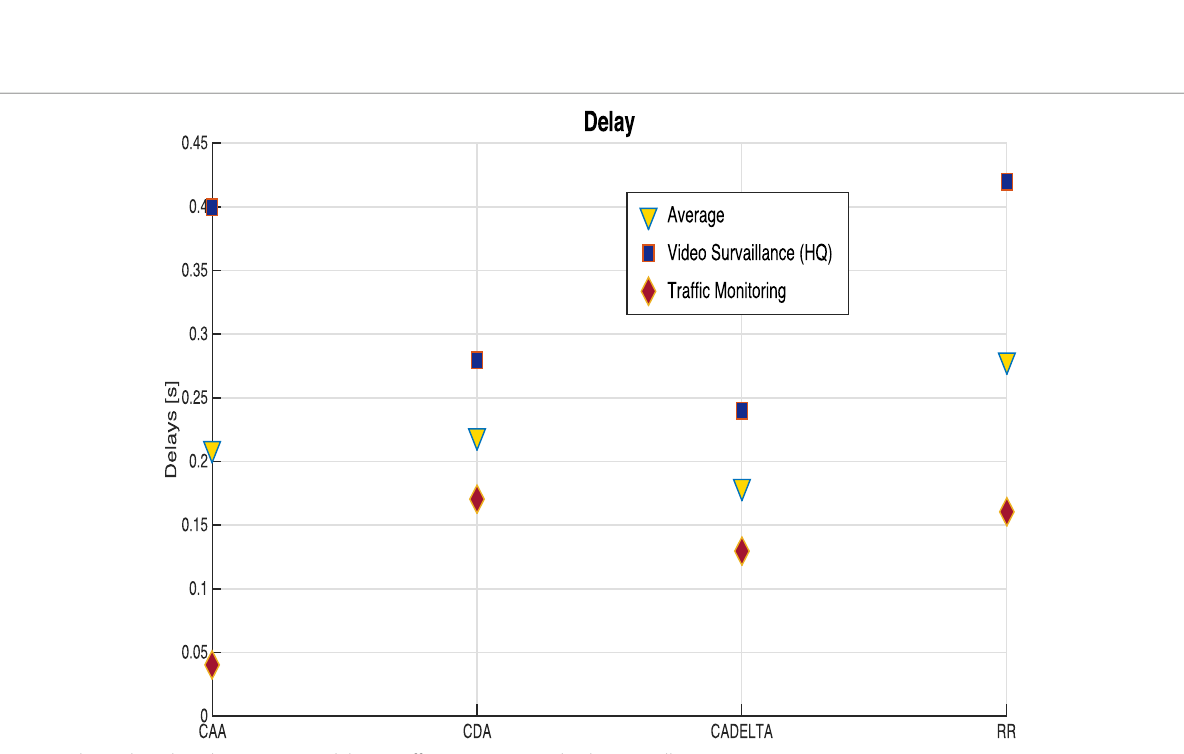
Fig. 16 Channel- and application-aware delay—traffic monitoring and video surveillance